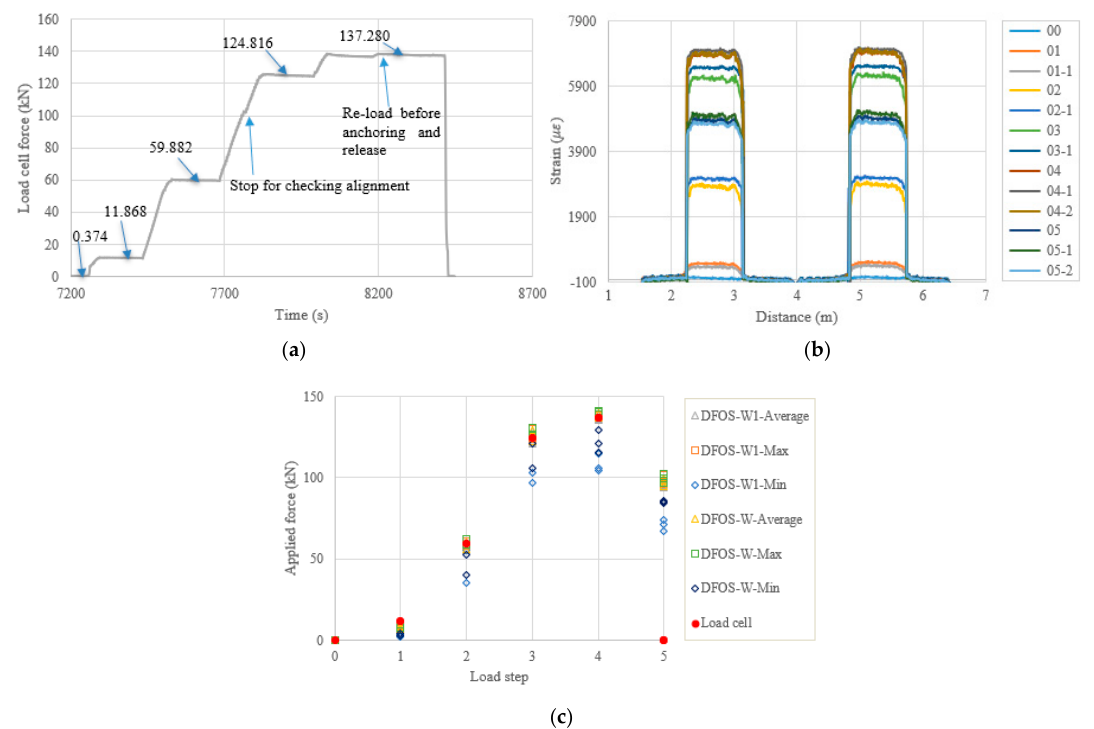
Figure 13. ( a ) Load cell readings for PC4-1; ( b ) strain distribution along the strand (W1 and W fibers) (In the legend, the first number represents the load step, and the second number represents measurement times at the load step); and ( c ) applied force changes at different load steps.